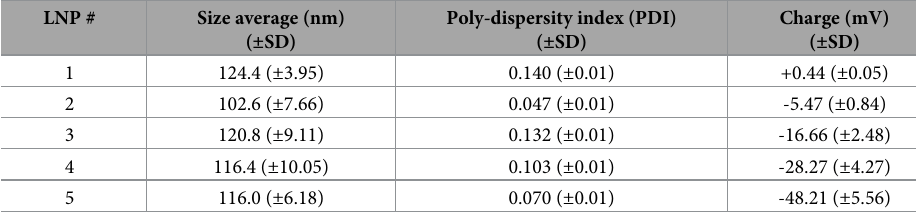
Table 2. Characterization of LNP used in this study.